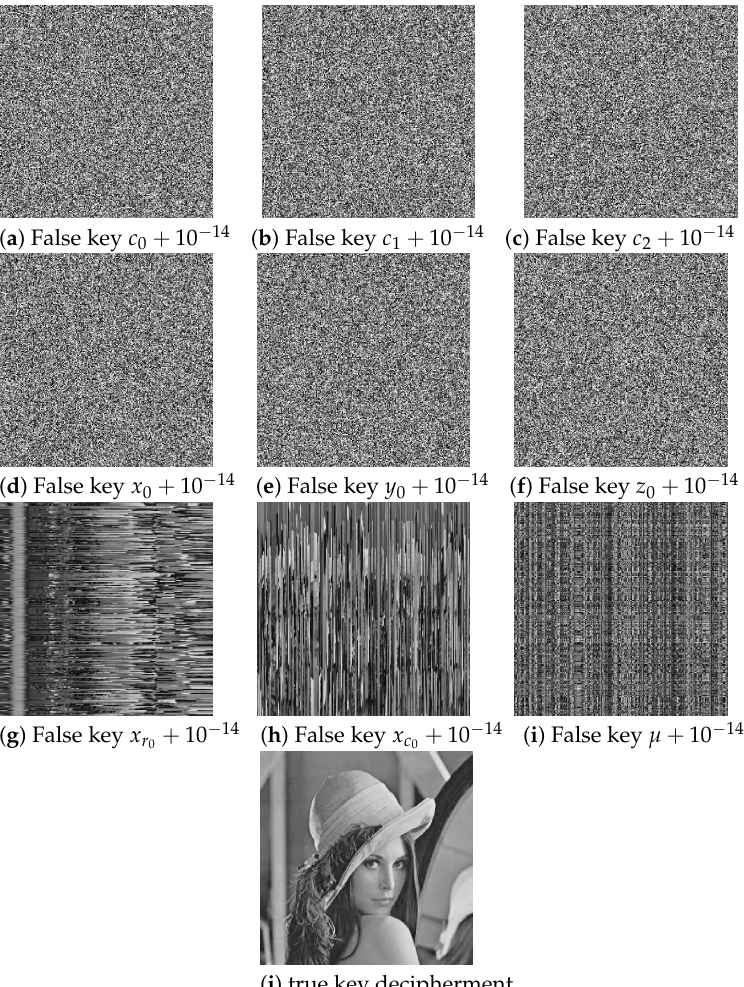
Figure 7. Key sensitivity analysis